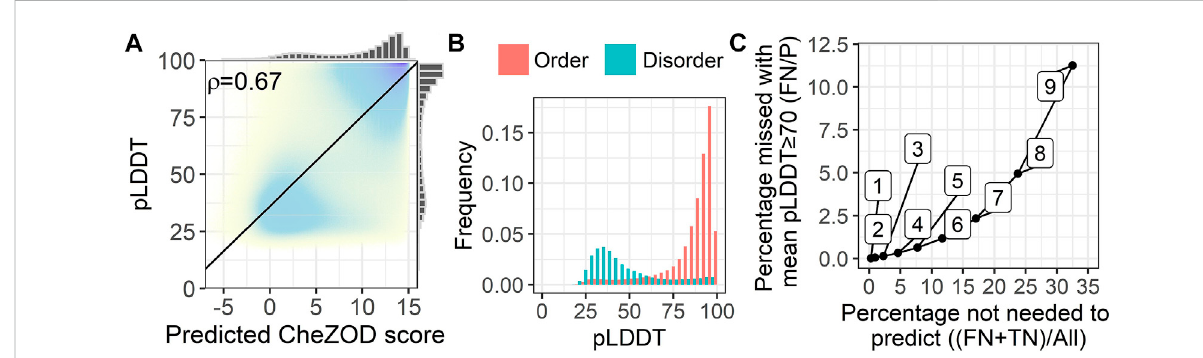
FIGURE 5 SETH ’ spredictionscorrelatedwithAlphaFold2 ’ spLDDT. Data:17-ORGANISM-set(47,400,204 residues from105,881proteinsin17organisms). (A) 2-dimensionalhistogramof AlphaFold2 pLDDT(Jumperetal.,2021)againstSETHdisorderpredictions(blackline:optimalregression fi t,marginal histogramsoneachaxis;number:overallSpearmancorrelationcoef fi cient ρ ,Eq.2). (B) HistogramsofthepLDDTof AlphaFold2 ,fortheclassesorder (predicted CheZOD > 8) and disorder (predicted CheZOD ≤ 8). (C) Cost versus gain analysis using SETH as a pre- fi lter for AlphaFold2 . Y -axis — Cost: The percentage of proteins with a mean predicted CheZOD score below a certain threshold (thresholds marked as numbers on the curve), but mean pLDDT ≥ 70 (FN) out of all proteins with mean pLDDT ≥ 70 (P). This gives the percentage of proteins with a pLDDT ≥ 70 missed using the SETH CheZOD score prediction as a pre- fi lter. X -axis — Gain: The percentage of proteins with mean CheZOD score < threshold (FN + TN) out of all proteins (All). This is the percentage of proteins in the entire dataset for which AlphaFold2 will not have to be run at all, or de fi nes a list of priority: fi rstrun AlphaFold2 ontheproteinswithlowerSETHdisorder.Forinstance,withthreshold8,aquarterofall AlphaFold2 predictionscanbeavoidedat an error rate of only 5%.